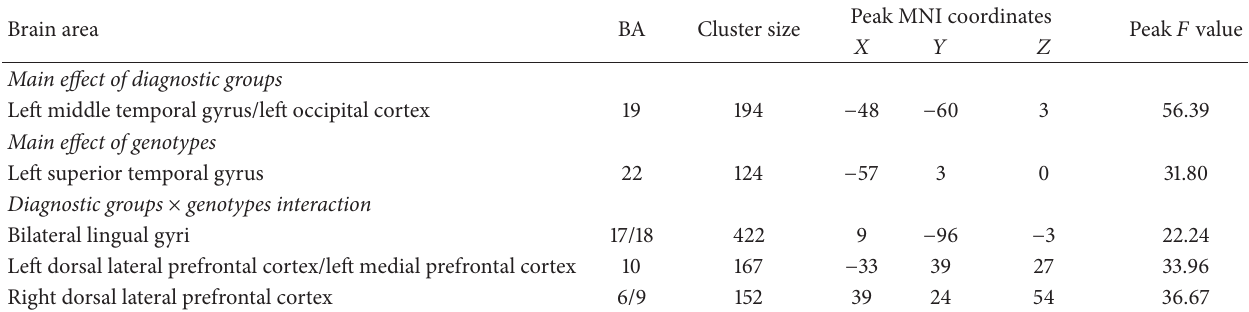
Table 2: Clusters exhibiting the influence of groups and genotypes on ALFF in the CC and CT/TT genetic subgroups in the MDD and HC. Brain area Main effect of diagnostic